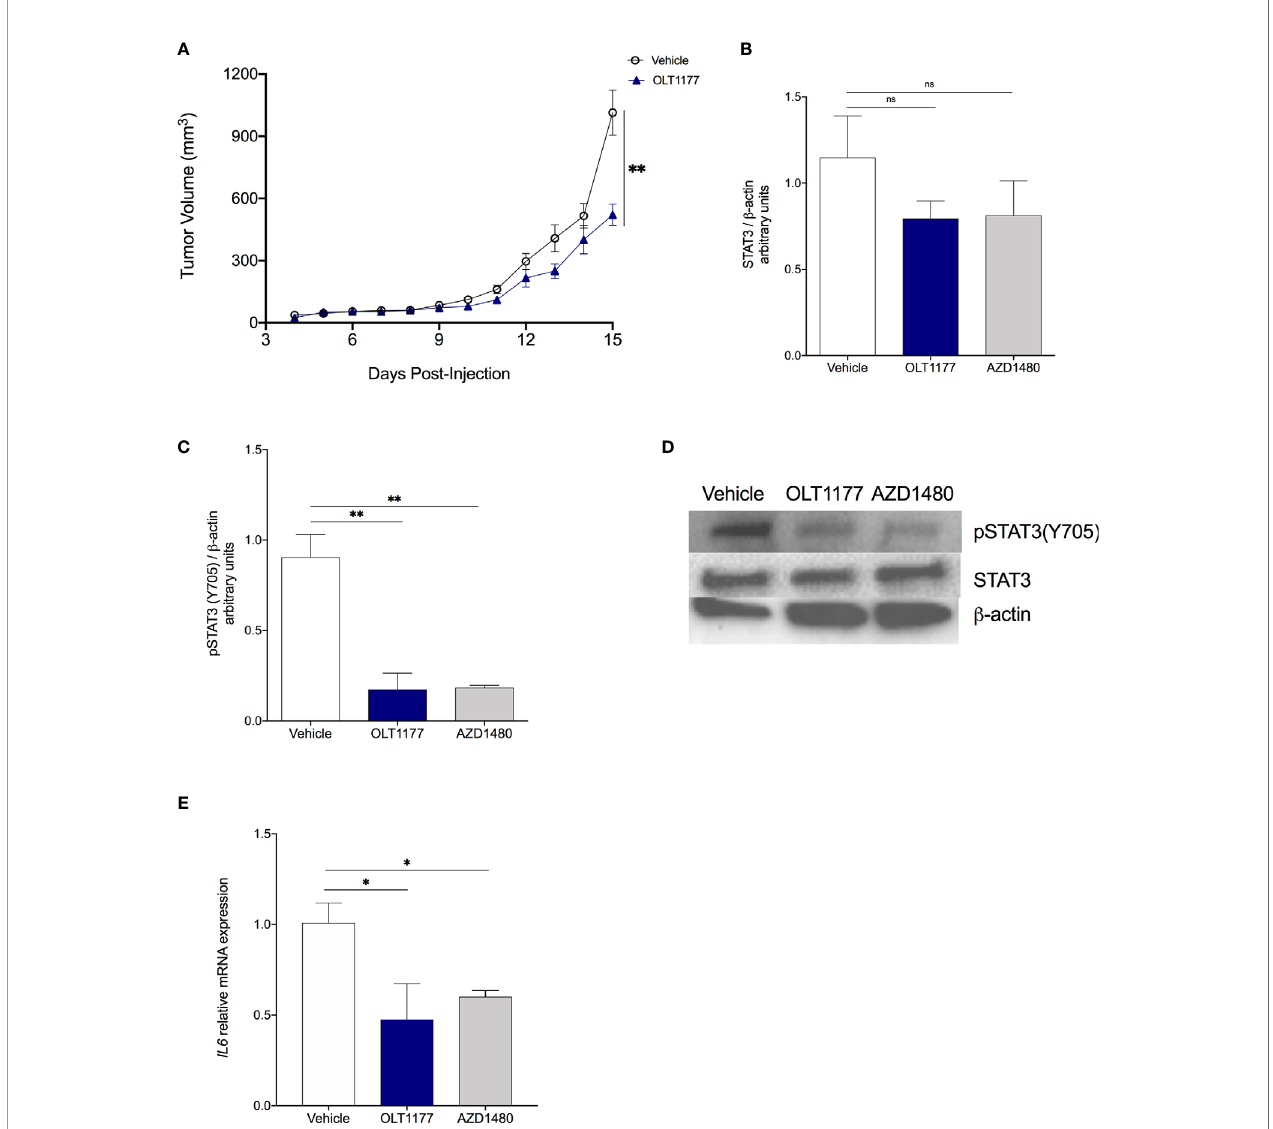
FIGURE 2 | NLRP3 inhibition disrupts IL-1 b -induced IL-6/STAT3 signaling in the TME. (A) Tumor growth in mice treated with saline control (Vehicle) or OLT1177 (OLT1177) (N=8/group). (B) Mean ± SEM of STAT3/ b -actin ratio in primary tumors of mice described in (A) (N=6). (C) Mean ± SEM of pSTAT3(Y705)/ b -actin ratio in primary tumors of mice described in (A) (N=6). (D) Representative western blot images from (C, D) . (E) Mean ± SEM of relative mRNA expression Il6 from primary tumors. ns (not signi fi cant), * p < 0.05, ** p <